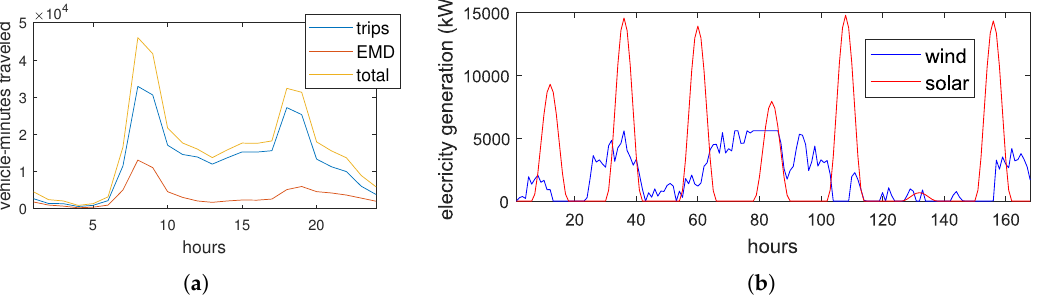
Figure 2. Transport demand and renewable energy generation. ( a ) EMD for trips from the transport survey during a day; and ( b ) Example of profiles for solar and wind power generation during a week.